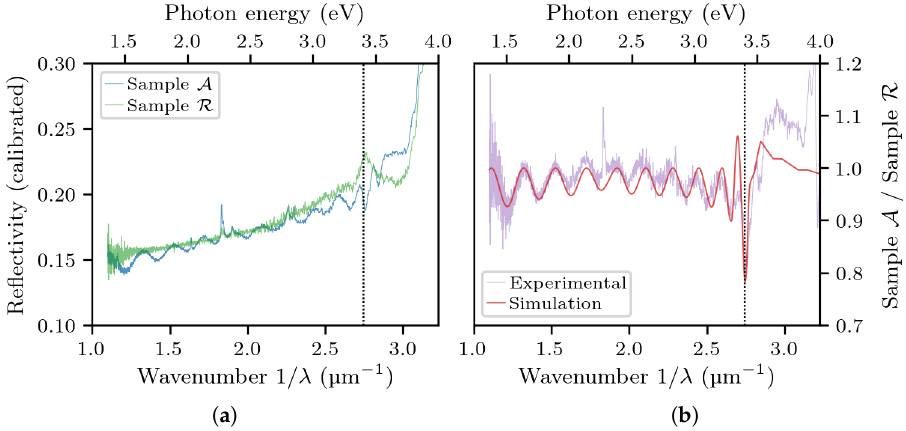
Figure 5. The reflectivity spectra of sample A and R ( a ) and their ratio with the simulation superim- posed ( b ). The vertical line marks the bandgap energy of undoped